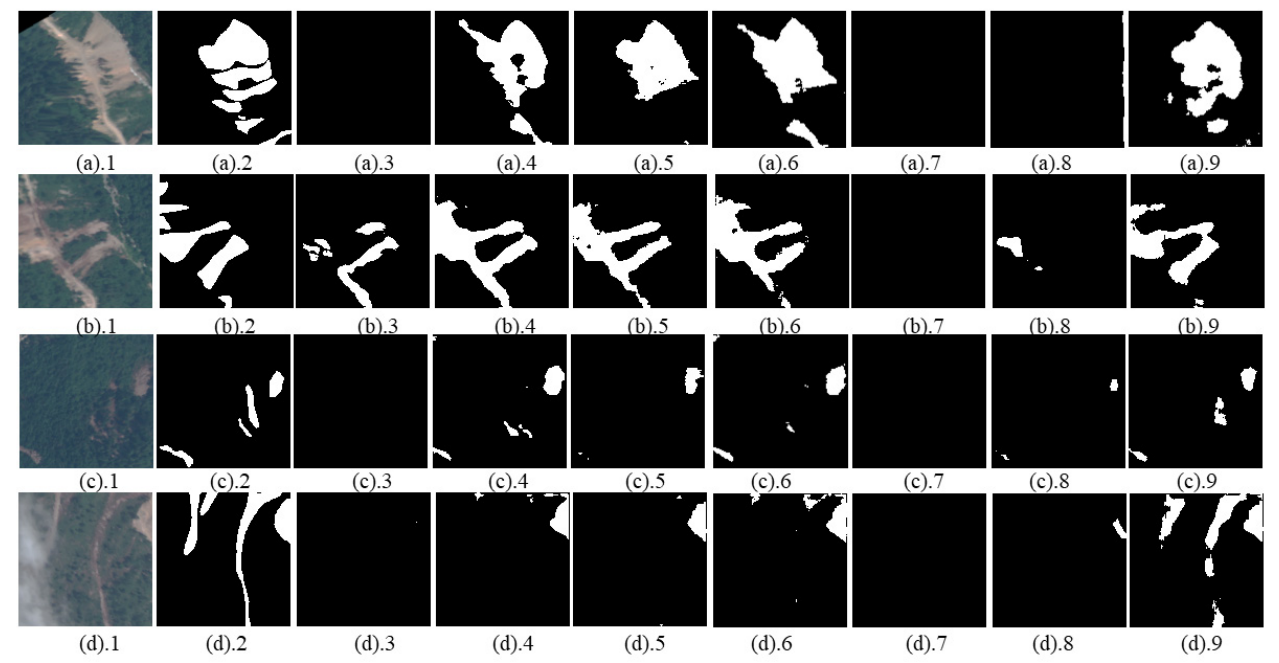
Figure 10. Visual comparison of landslide detection on images of the Jiuzhaigou landside dataset between our proposed DeenNet and the other networks: (*).1 indicate the original image patches, (*).2 represent the ground-truth image patches, (*).3–(*).8 are the results of U-net, U-net + residual module, SegNet, SegNet + residual module, Deeplabv3, and Deeplabv3+ residual module, respec- tively, and (*).9 represent images detected by our DeenNet.